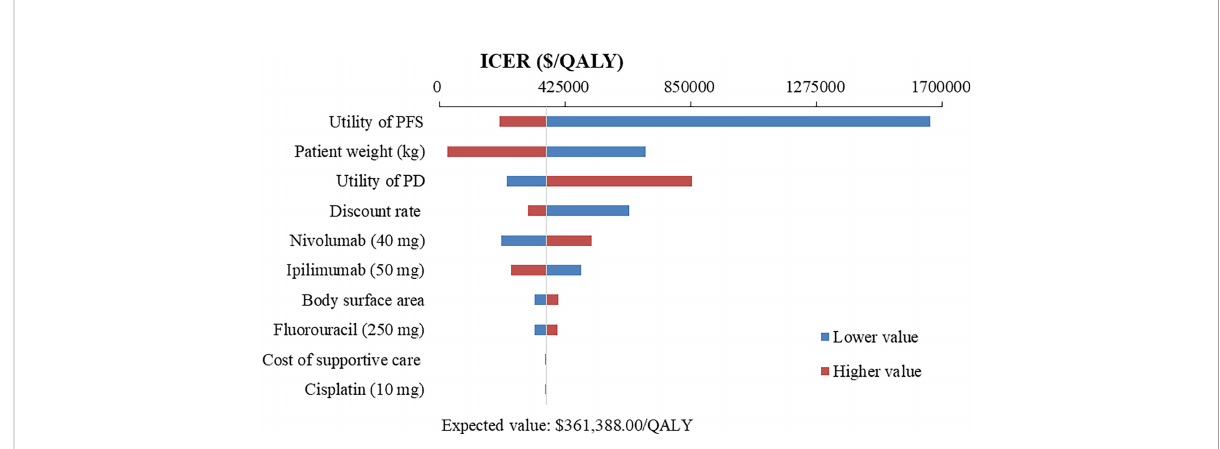
FIGURE 4 Tornado diagram of one-way sensitivity analysis of Nivolumab plus chemotherapy versus Nivolumab plus ipilimumab in the treatment of overall advanced ESCC patients. ICER, incremental cost-effectiveness ratio; QALY, quality-adjusted life year; PFS, progression-free survival; PD, progressive